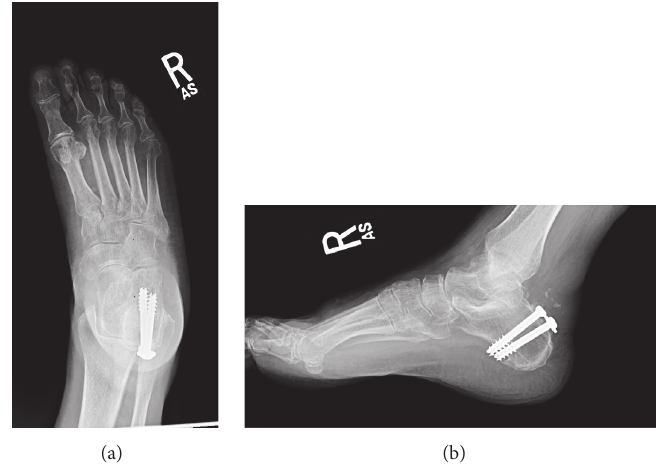
Figure 3: Anteroposterior (a) and lateral (b) radiographs showing complete healing of the